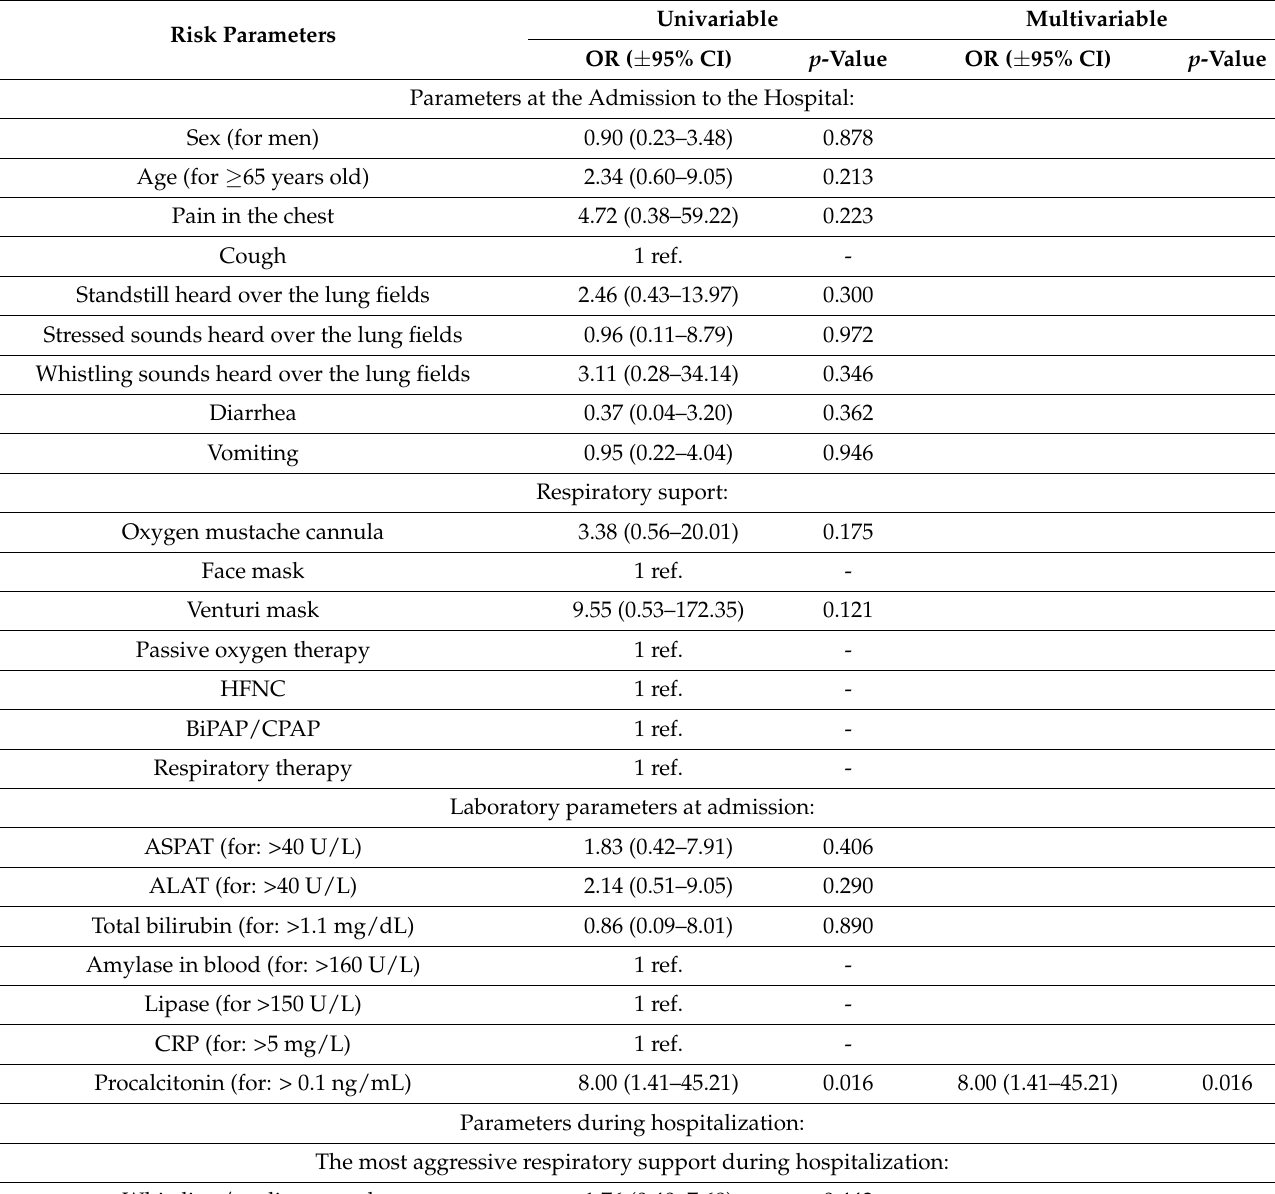
Table 5. Univariable and multivariable logistic regression analysis of selected variables as predictors of death in group of patients with abdominal pain ( n =